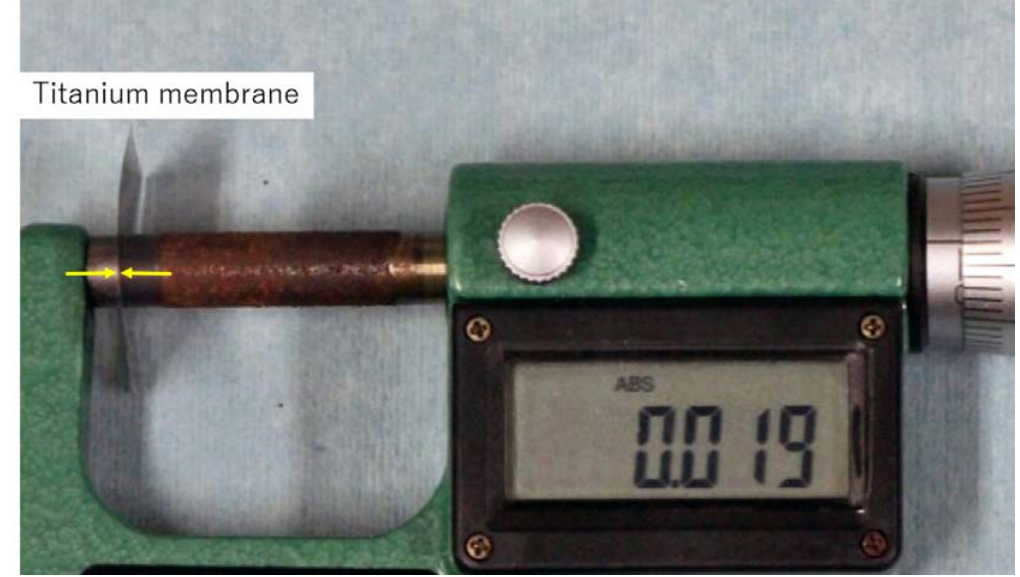
Figure 2. Measurement of thickness. Between yellow arrows indicate of sample thickness.